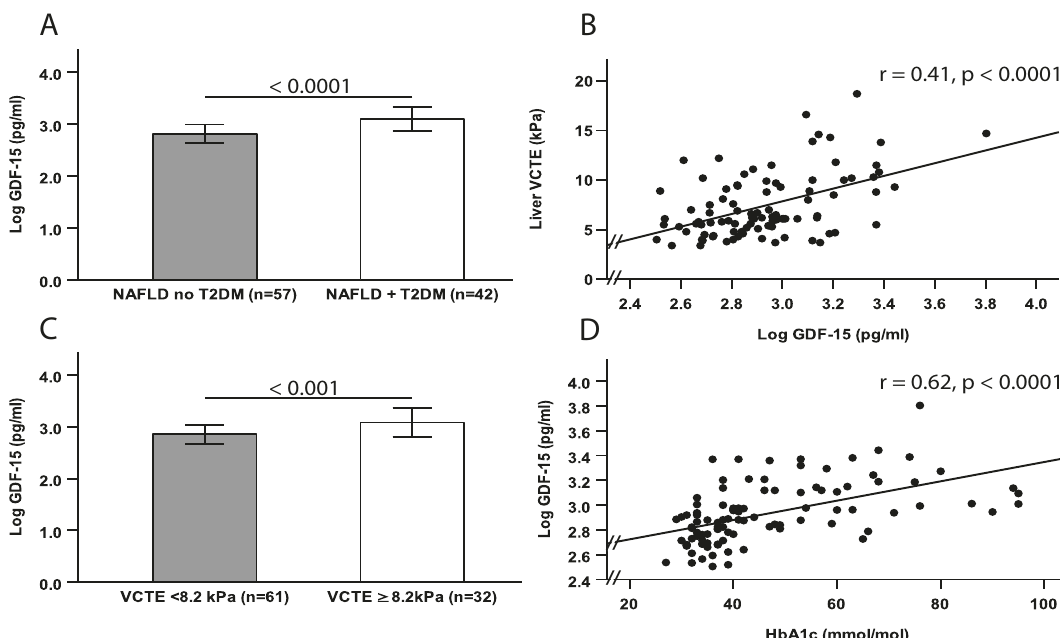
Fig. 1 Differences in serum GDF-15 concentrations by type 2 diabetes status, predicted liver fi brosis severity and scatter plots showing the association between serum GDF-15 concentrations and both haemoglobin A1c and liver stiffness measurements (as assessed by vibration-controlled transient elastography [VCTE]). A The differences in serum GDF-15 concentrations (logarithmically transformed) between NAFLD patients with and without coexisting type 2 diabetes. B The scatter plot for the association of serum GDF-15 concentrations with liver VCTE measurements (kPa). C The differences in serum GDF-15 concentrations between NAFLD patients with <F2 or ≥ F2 fi brosis according to the validated VCTE measurement threshold of ≥ 8.2 kPa as a proxy for the identi fi cation of ≥ F2 fi brosis. D The scatter plot for the association of serum GDF-15 with HbA1c concentrations. Data are presented as mean ± SD. Associations are Spearman ’ s rank correlation coef fi cients. Sample size A , D n = 99; B , C n = 93. VCTE vibration-controlled transient elastography, GDF-15 growth differentiation factor-15, T2DM type 2 diabetes